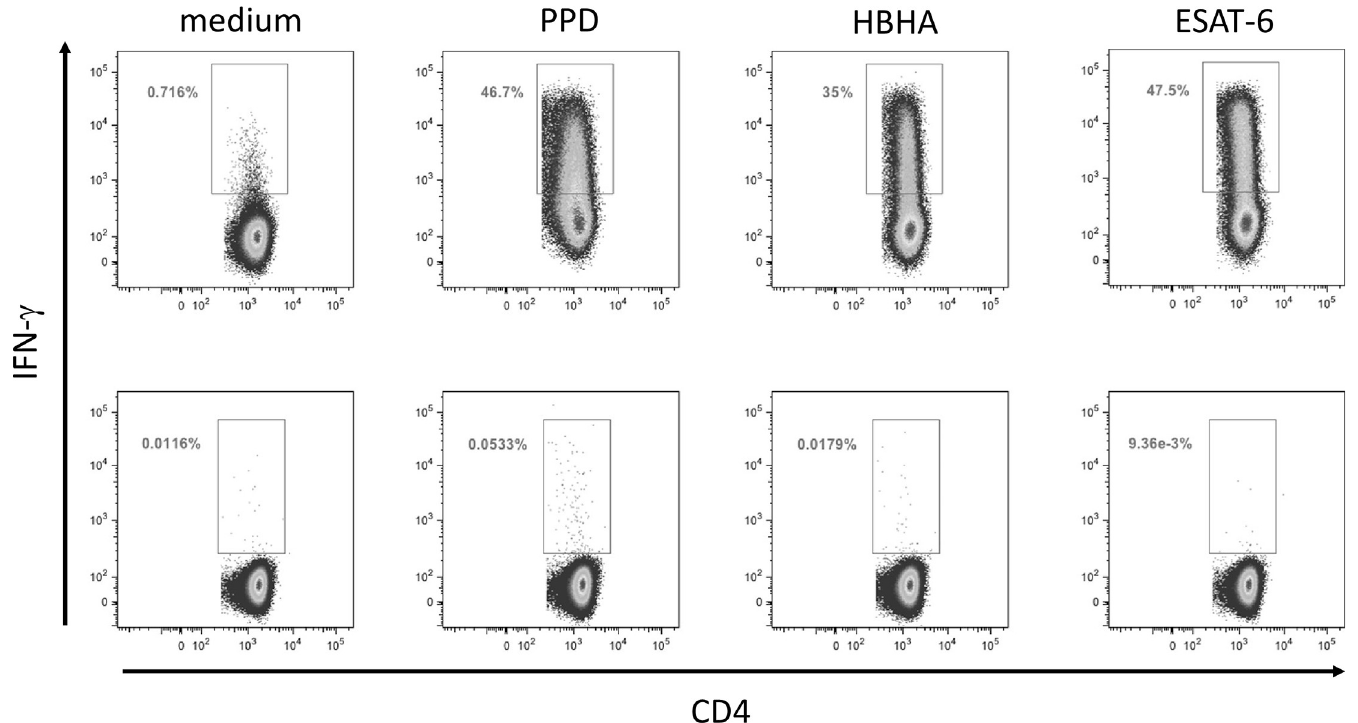
Fig 2. Representative dot-plots of the flow cytometry analyses for one TB patient (upper panel) and one non-TB patient (lower panel). Ascites lymphocytes were in vitro cultured overnight in the absence (medium) or the presence of PPD, HBHA or ESAT-6, as indicated. IFN- γ -producing CD4 + T cells are shown after a sequential gating of Forward Scatter (FSC)/Side scatter (SSC), single cells and CD3 + T lymphocytes. The percentages of IFN- γ + T lymphocytes in each condition are indicated.